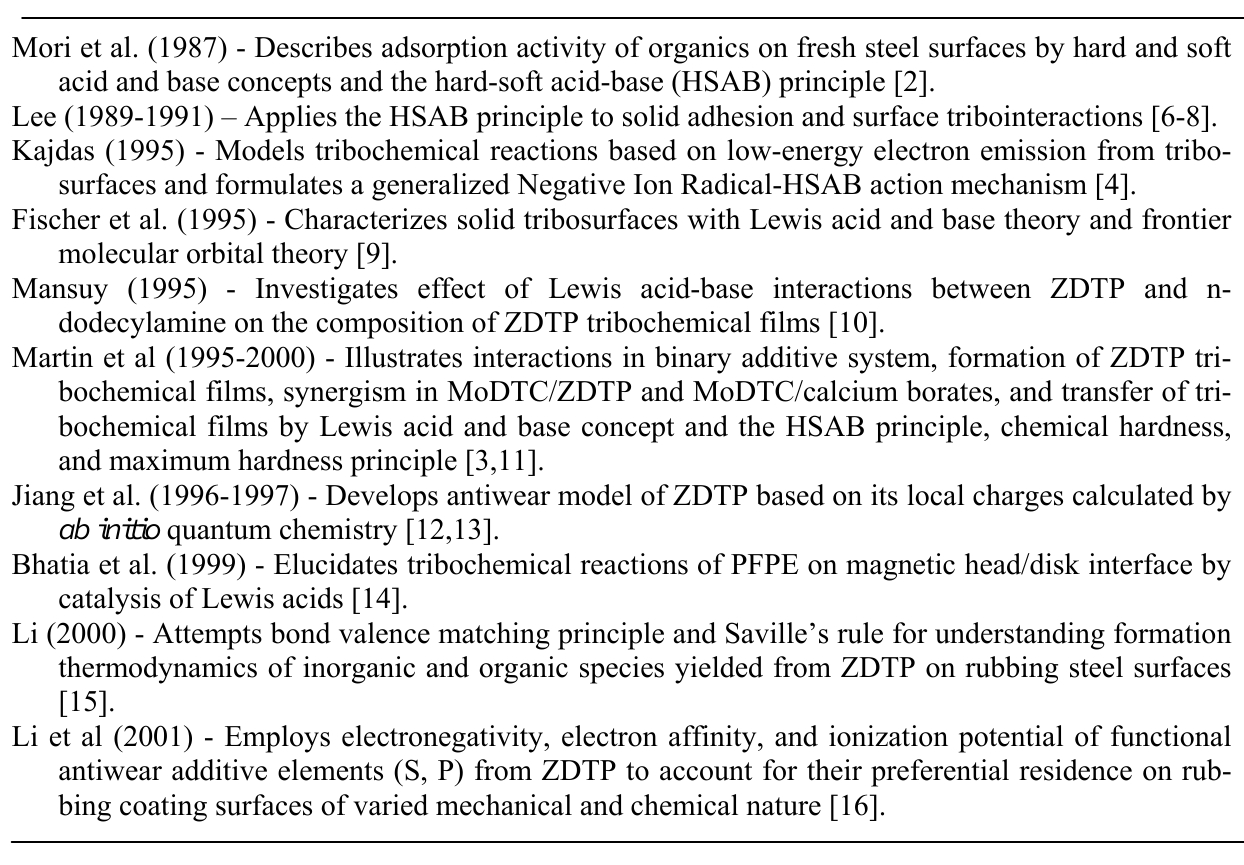
Table 1. A chronological listing of Lewis acid and base concepts and principles used in previous fundamental tribochemistry study